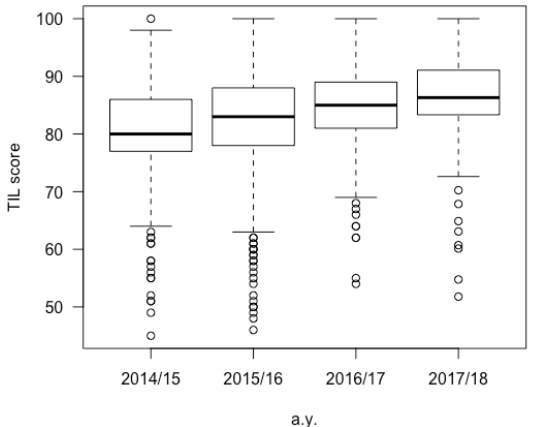
Fig. 3. Boxplot of the TIL score related to students of each